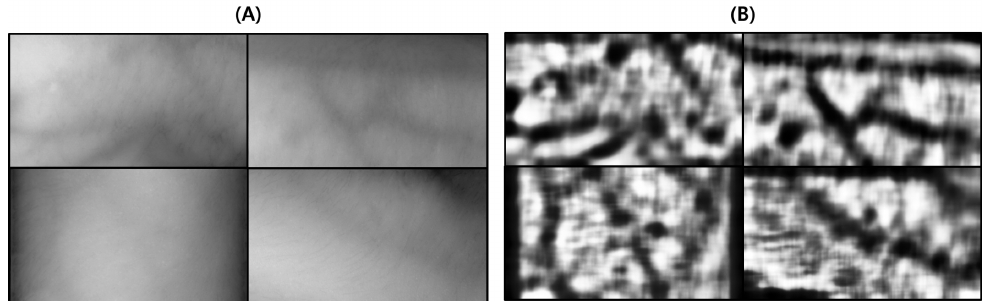
Figure 4. Vein images with histogram normalization and equalization applied: ( A ) is the original image, and ( B ) is the result of applying histogram equalization. The contrast of venous vessels became clear through histogram